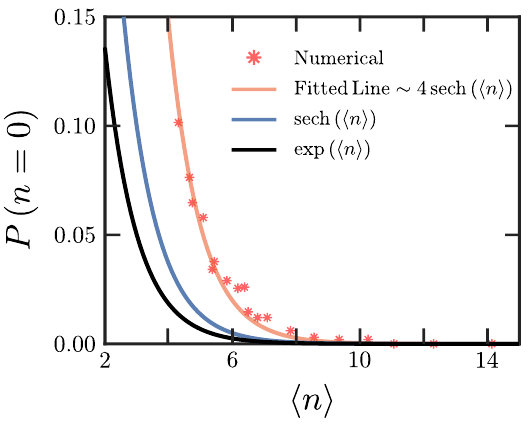
Figure 9 . Probability distribution of P ( n = 0) with respect to the average number of vortices h n i . Numerical results are consistent with theoretical EP distribution (red line) up to an O (1) factor. Black line is the (unrestricted) Poissonian